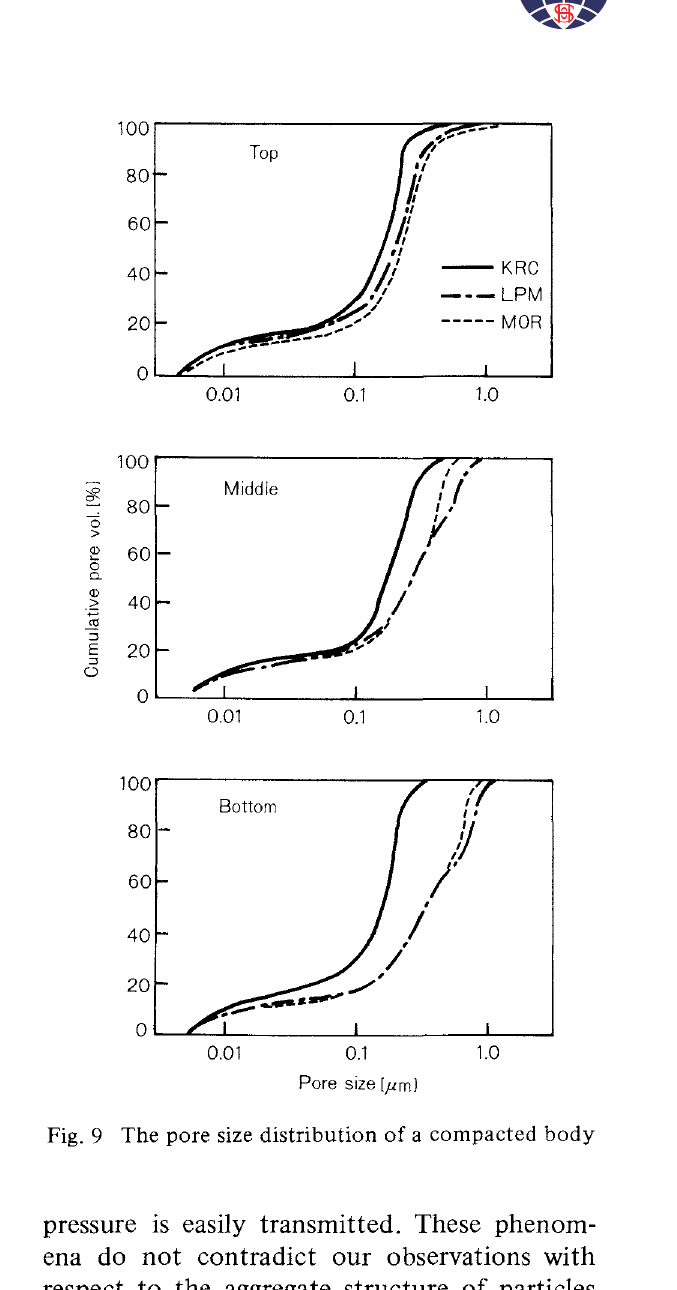
Fig. 9 The pore size distribution of a compacted